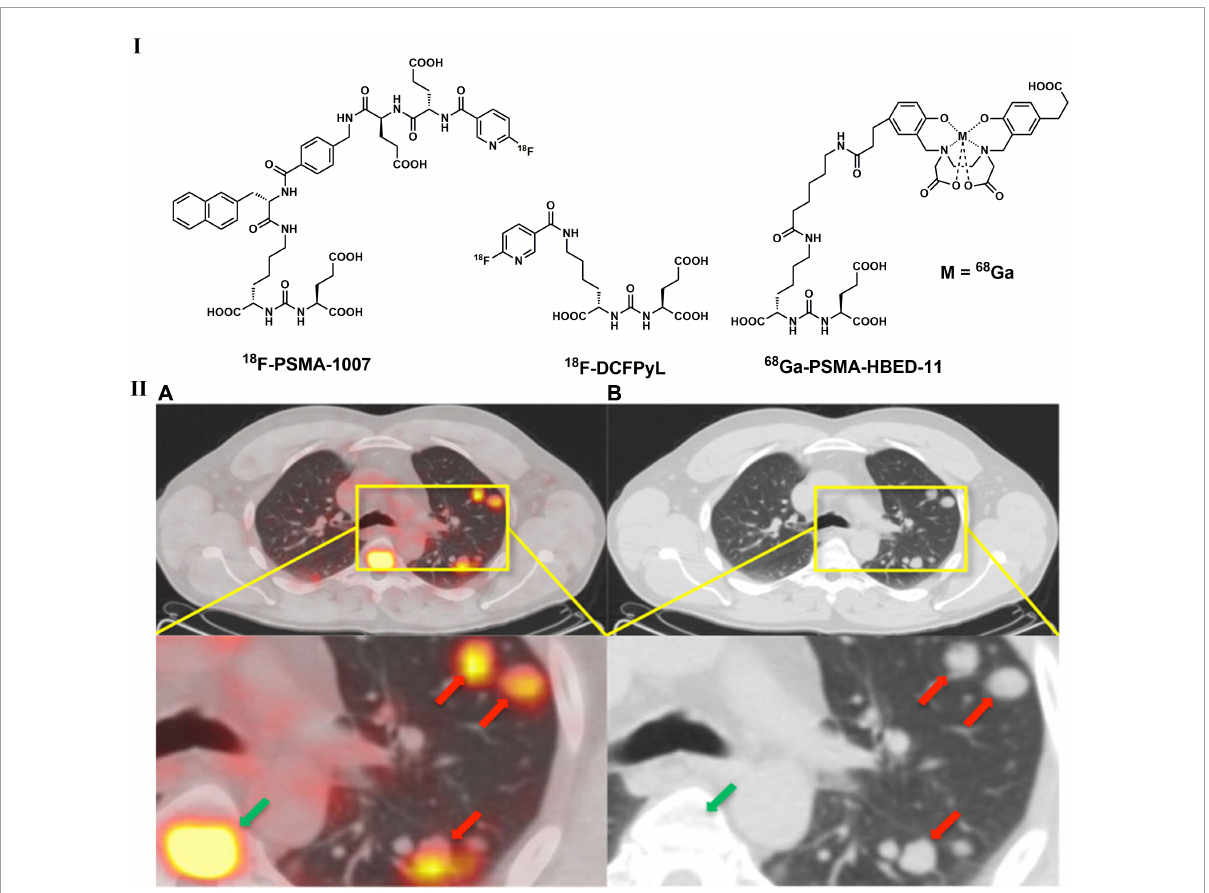
FIGURE8 Structures of representative PSMA-targeted PET tracers (I) and PET/CT (A) and unenhanced CT (B) images of 68 Ga-PSMA-HBED-11 in patient with with a recurrent prostate acinar adenocarcinoma and lung metastases (II)